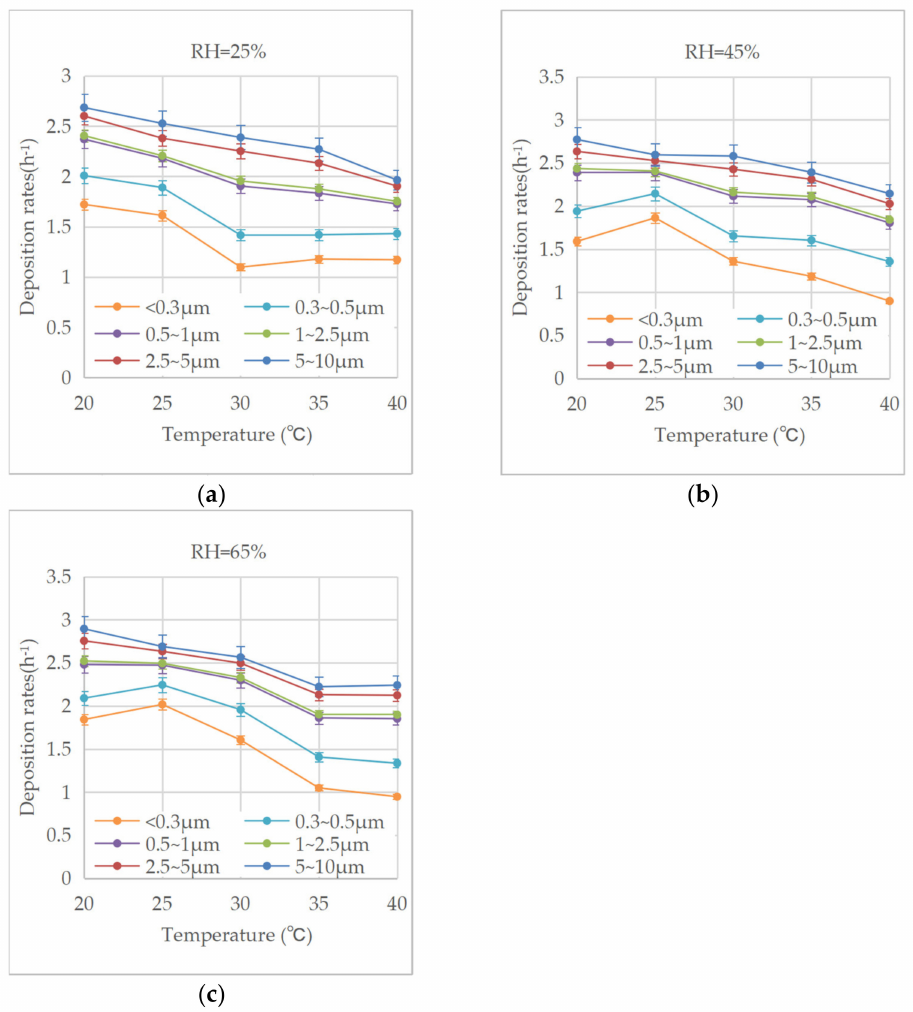
Figure 6. ( a ) Variation in deposition rates with ambient temperature under RH = 25%. ( b ) Variation in deposition rates with ambient temperature under RH = 45%. ( c ) Variation in deposition rates with ambient temperature under RH =